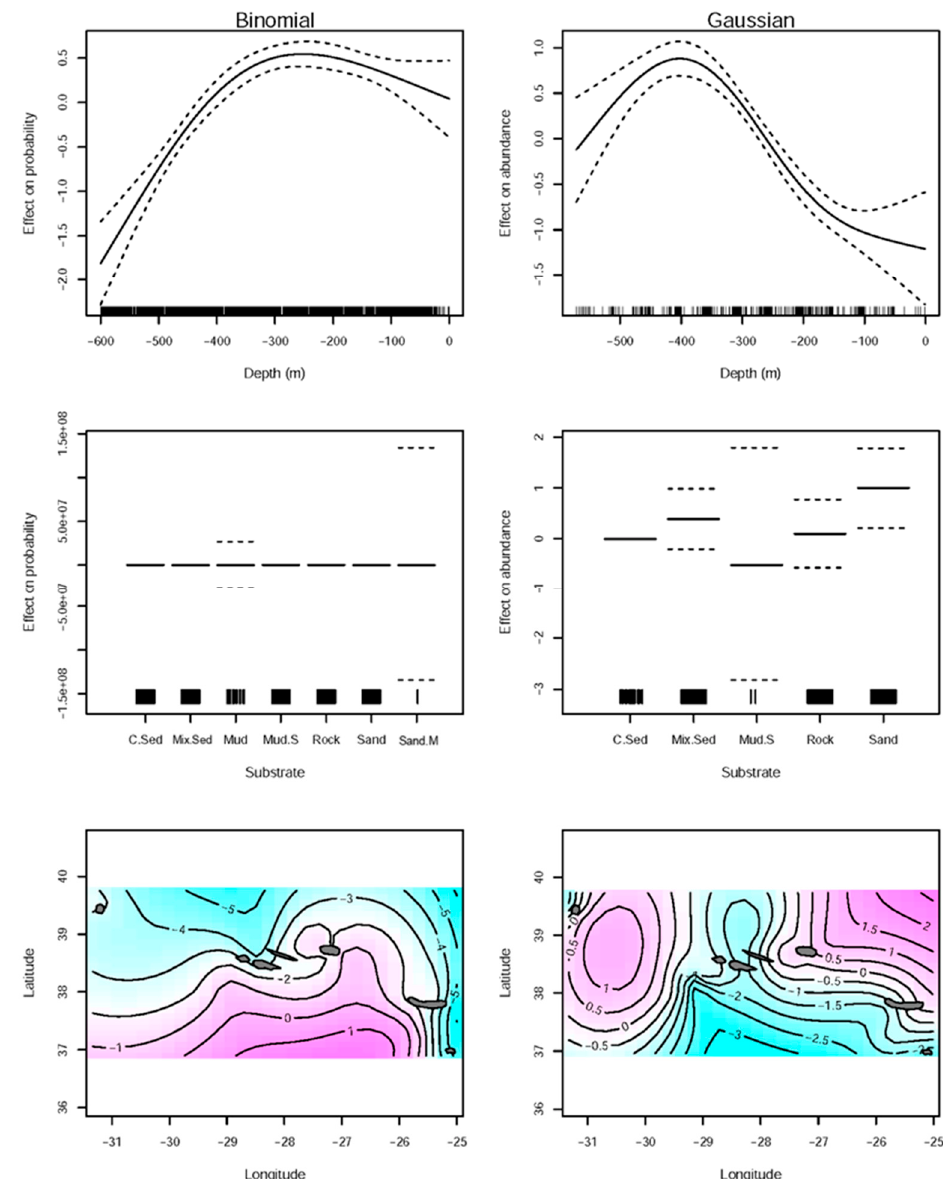
Figure 2. Residual plots of the binomial (the left column of plots) and Gaussian (right column of the plots) generalized additive models (GAMs) developed to predict and determine the effect of the environmental variables in the spatial distribution (presence–absence and abundance) of Lepidopus caudatus in the Azorean waters. In the plots of depth and substrate type, each mark along the x-axis corresponds to a single observation and dashed lines correspond to the 95% confidence intervals. The purple color from the longitude and latitude plot represents a higher probability of occurrence or abundance in determined latitude and longitude, and the blue color indicates less probability or less abundance of